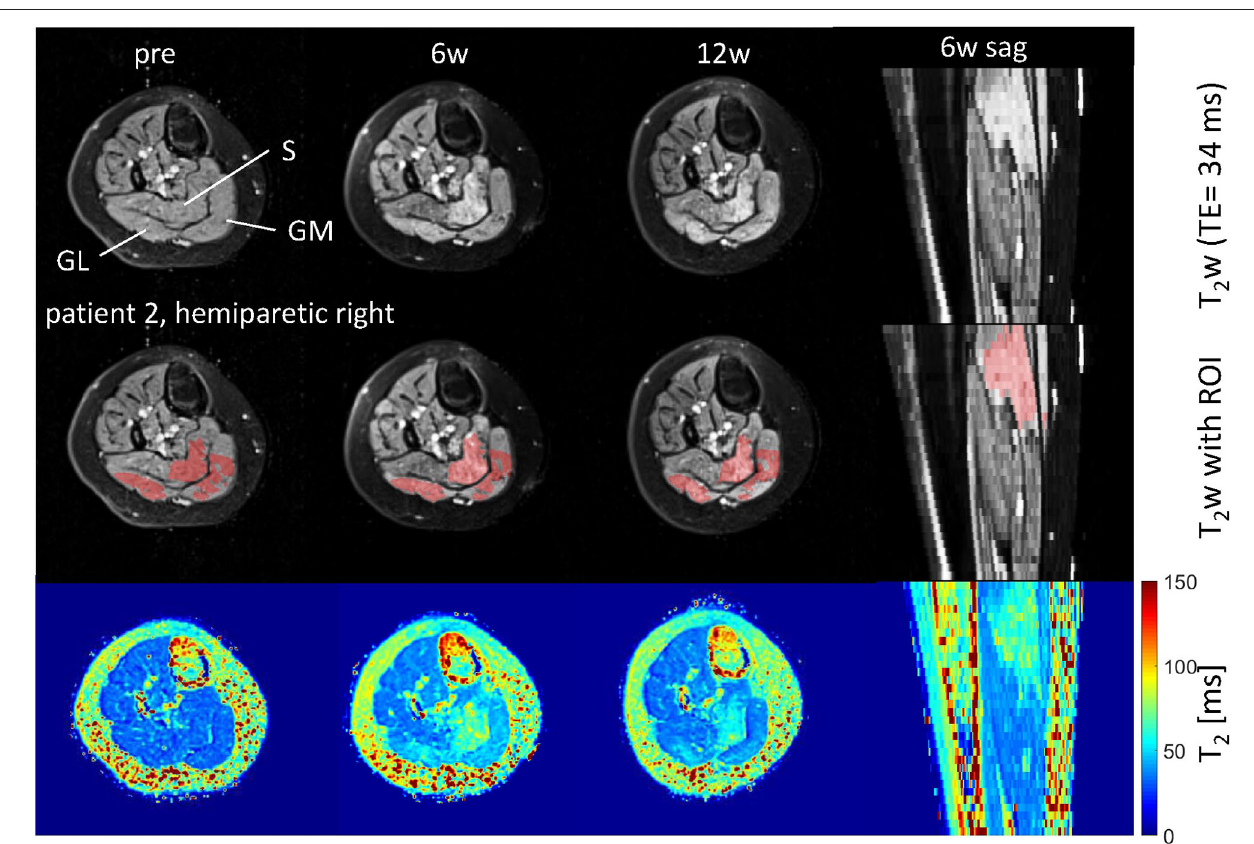
FIGURE 1 | Axial and sagittal T 2 -weighted images in the calf of patient 2 (hemiparetic) pre-BTX and 6 weeks (6w) and 12 weeks (12w) post-BTX (top row) showing hyperintensity at the sites of injection in the soleus (S), gastrocnemius medialis, and lateralis (GM, GL). A region of interest (ROI) comprising the hyperintense regions was segmented and is shown as red overlay in the middle row. The increased T 2 post-BTX can be seen in the calculated T 2 maps (bottom row). BTX, botulinum toxin A; y, years; T 2 w, T 2 -weighted; TE, echo time; sag,